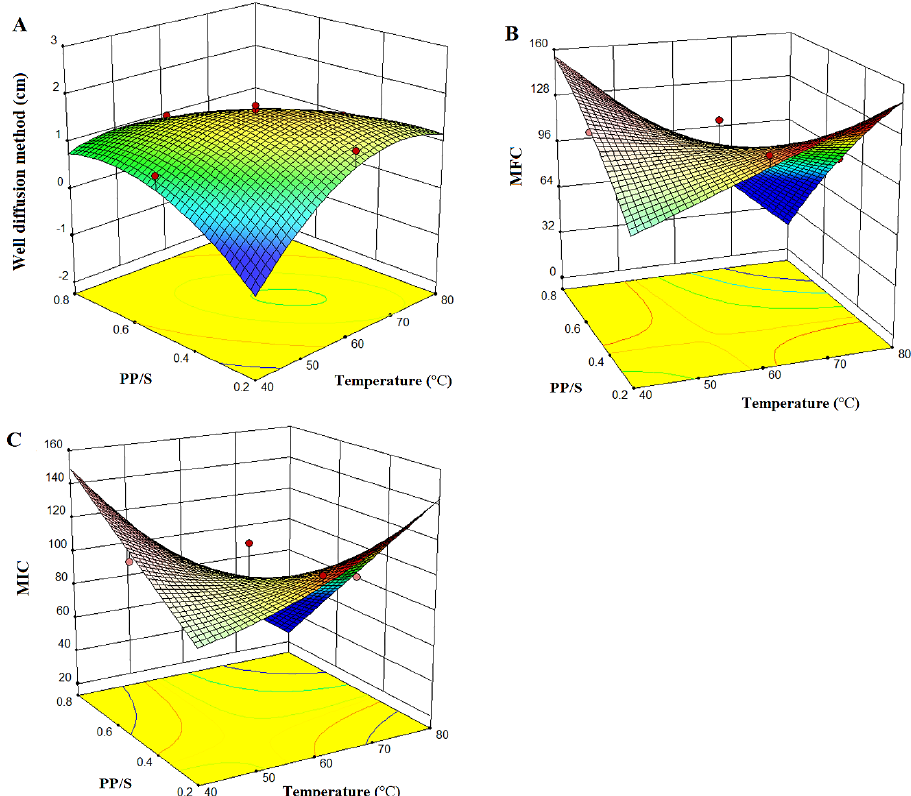
Figure 5. Response Surface of the Size of the WDM (A), MFC (B) and MIC (C) as a Function of Temperature and PP/S at the Time of 6.5 h. Note . WDM, well diffusion method; MFC, minimum fungicidal concentration; MIC, minimum inhibitory concentration.